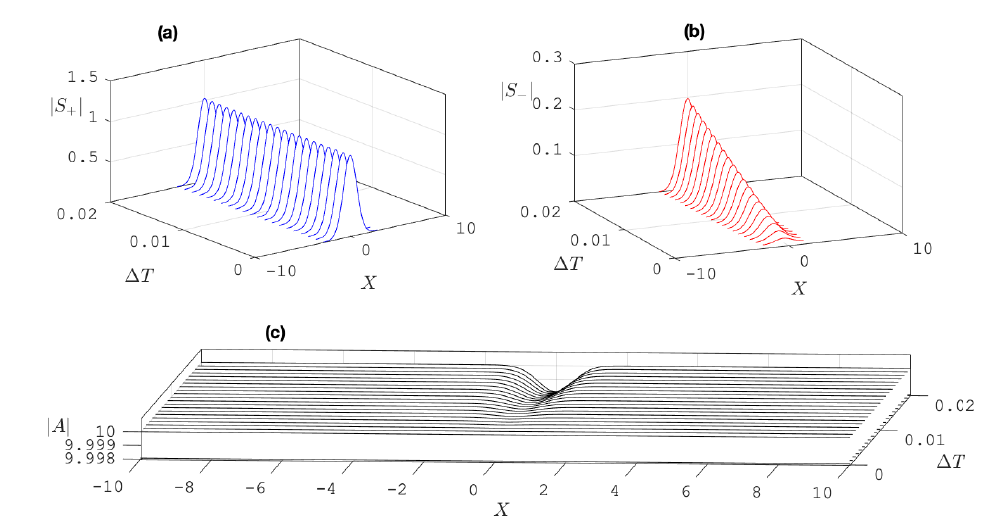
Figure 4. Amplitude evolution of the time reversal triad: ( a ) original disturbance; ( b ) time reversed disturbance; ( c ) acoustic mode; n = 0; A |